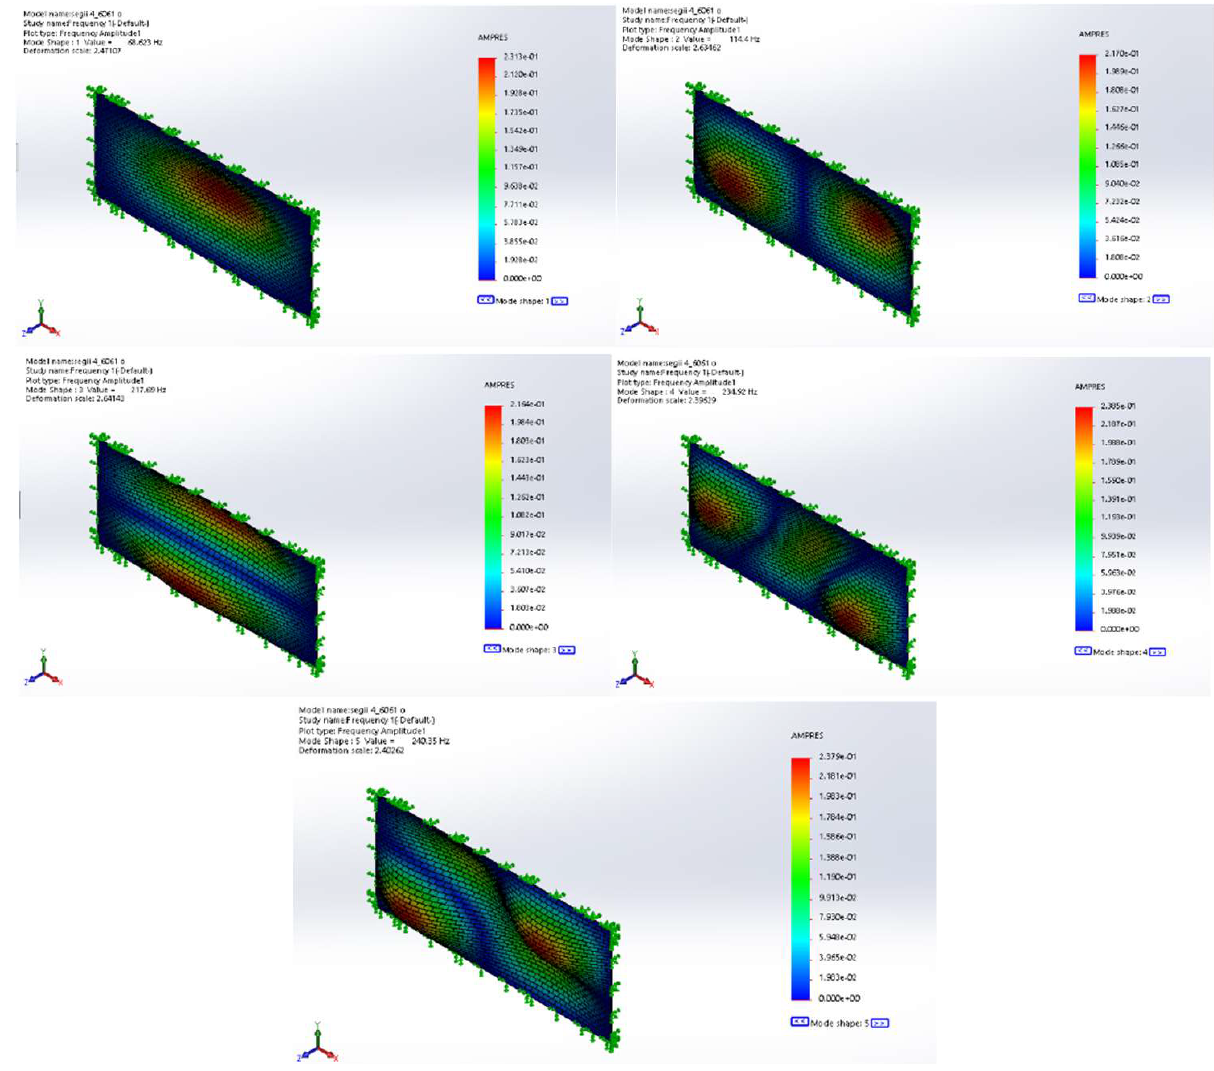
Figure 28: Mode shapes 1–5 of the square